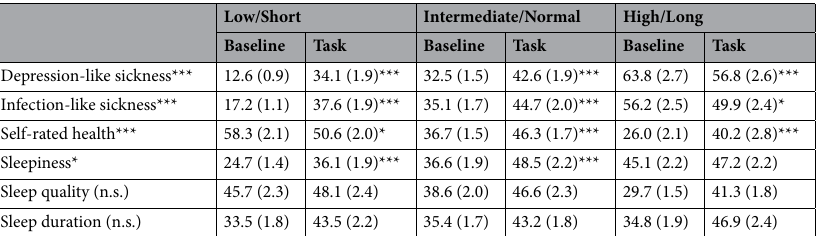
Table 3. Frustration levels (means and SEM) at baseline and during the frustration tolerance task, for the groups with low, intermediate, and high levels of sickness and sleep health stressors (the sleep duration groups was divided into short, normal, and long sleepers). Note that low depression-like sickness, low infection-like sickness, and low sleepiness indicate better health (i.e., less stress), while low sleep quality and low self-rated health indicate a worse level of the stressor. Short sleep duration refers to < 7 h, normal sleep duration refers to ≥ 7 to < 9 h, and long sleep duration to ≥ 9 h. n.s. = non-significant interaction between the stressor and task- induced frustration. *in the first column indicates significance level for interaction effects between the stressor and task effect (baseline, task). Other columns with * indicate significance level for post-hoc task comparisons (baseline, task) for each stressor level in case a significant interaction effect was evident, *p < .05, **p < .01, ***p <